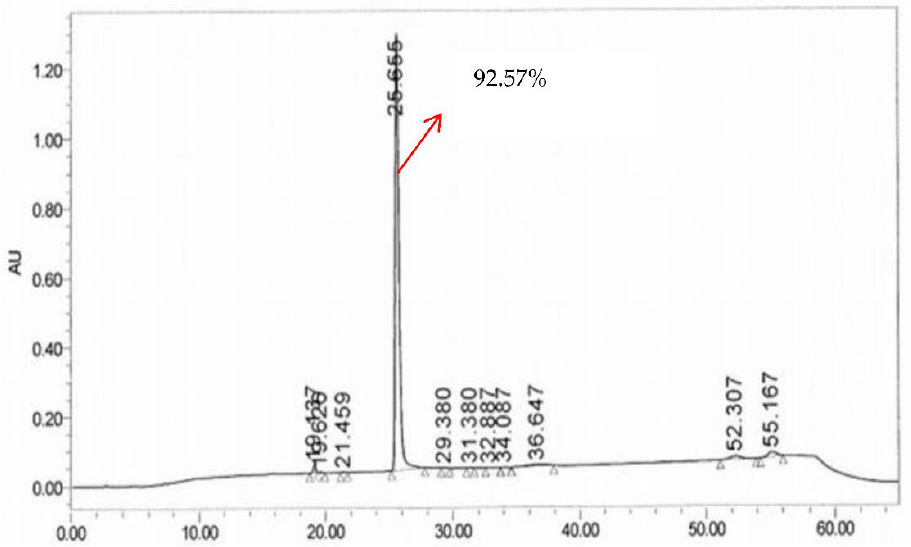
Figure 2. HPLC of